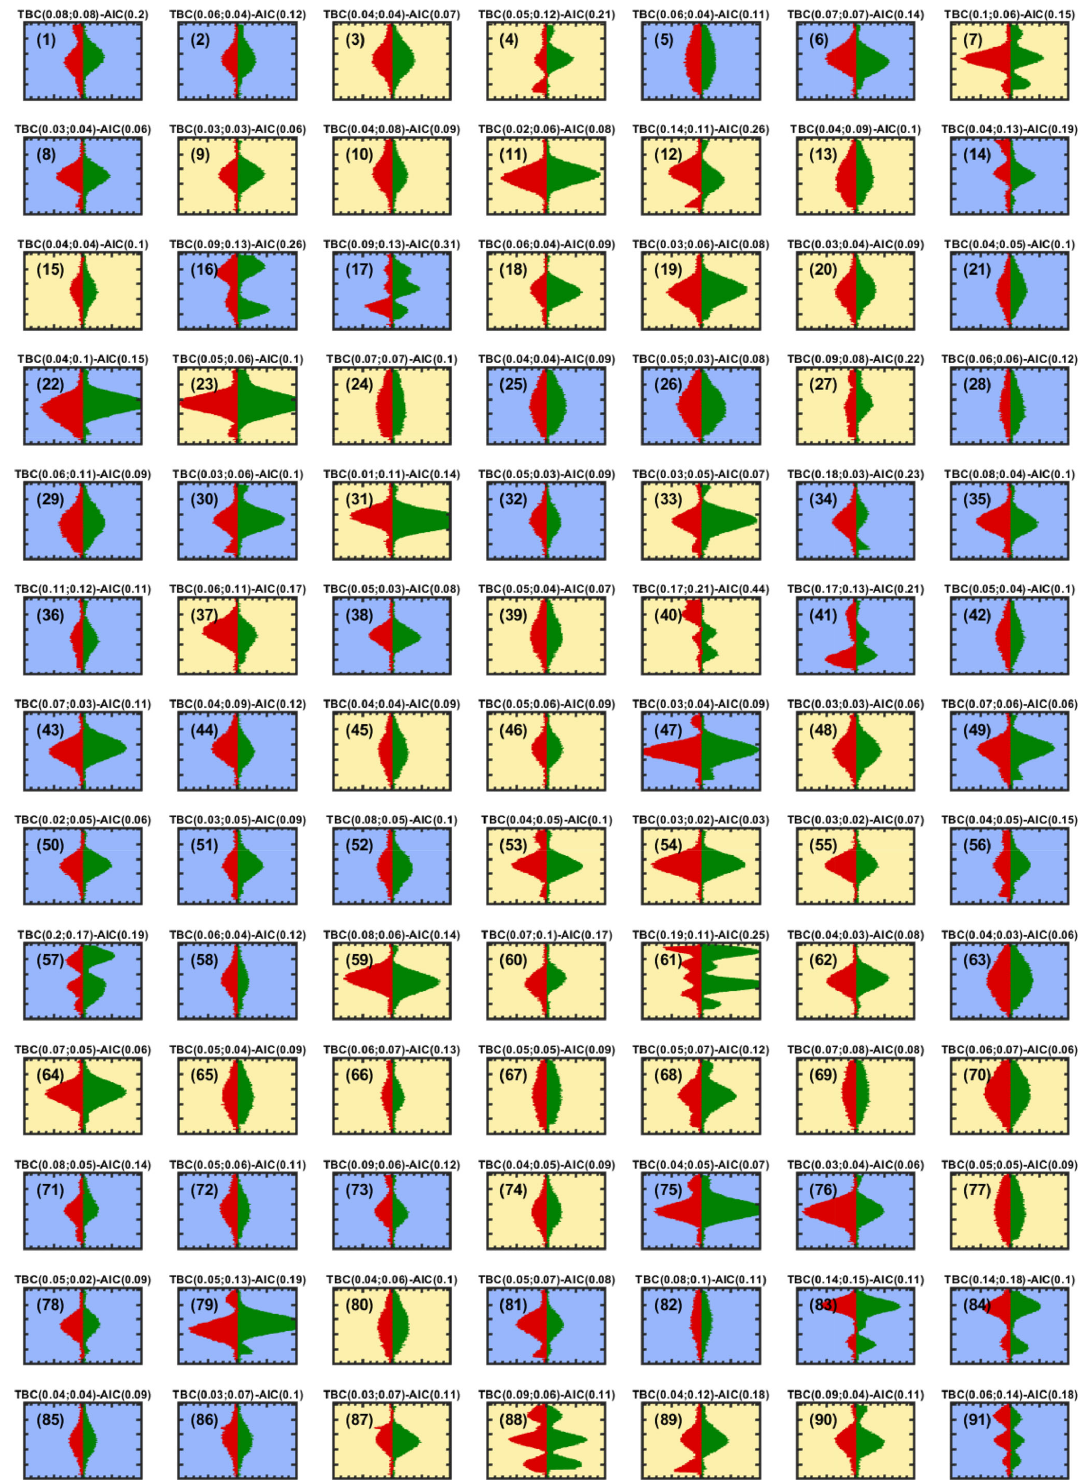
Figure 8. Collection of example particle intensity patterns imaged with PPD-HS during period 1 (where misclassification is high) of the experiment shown in Fig. 7. All scattering patterns are shown on the same intensity scale (40a.u.). Background color of the individual scattering patterns indicates that the particle classification by the random forest model into target classes is spherical (blue) or aspherical (yellow). The values on top of each panel depict the TBC, where the first number corresponds to array 1 and the second number to array 2, respectively, and the